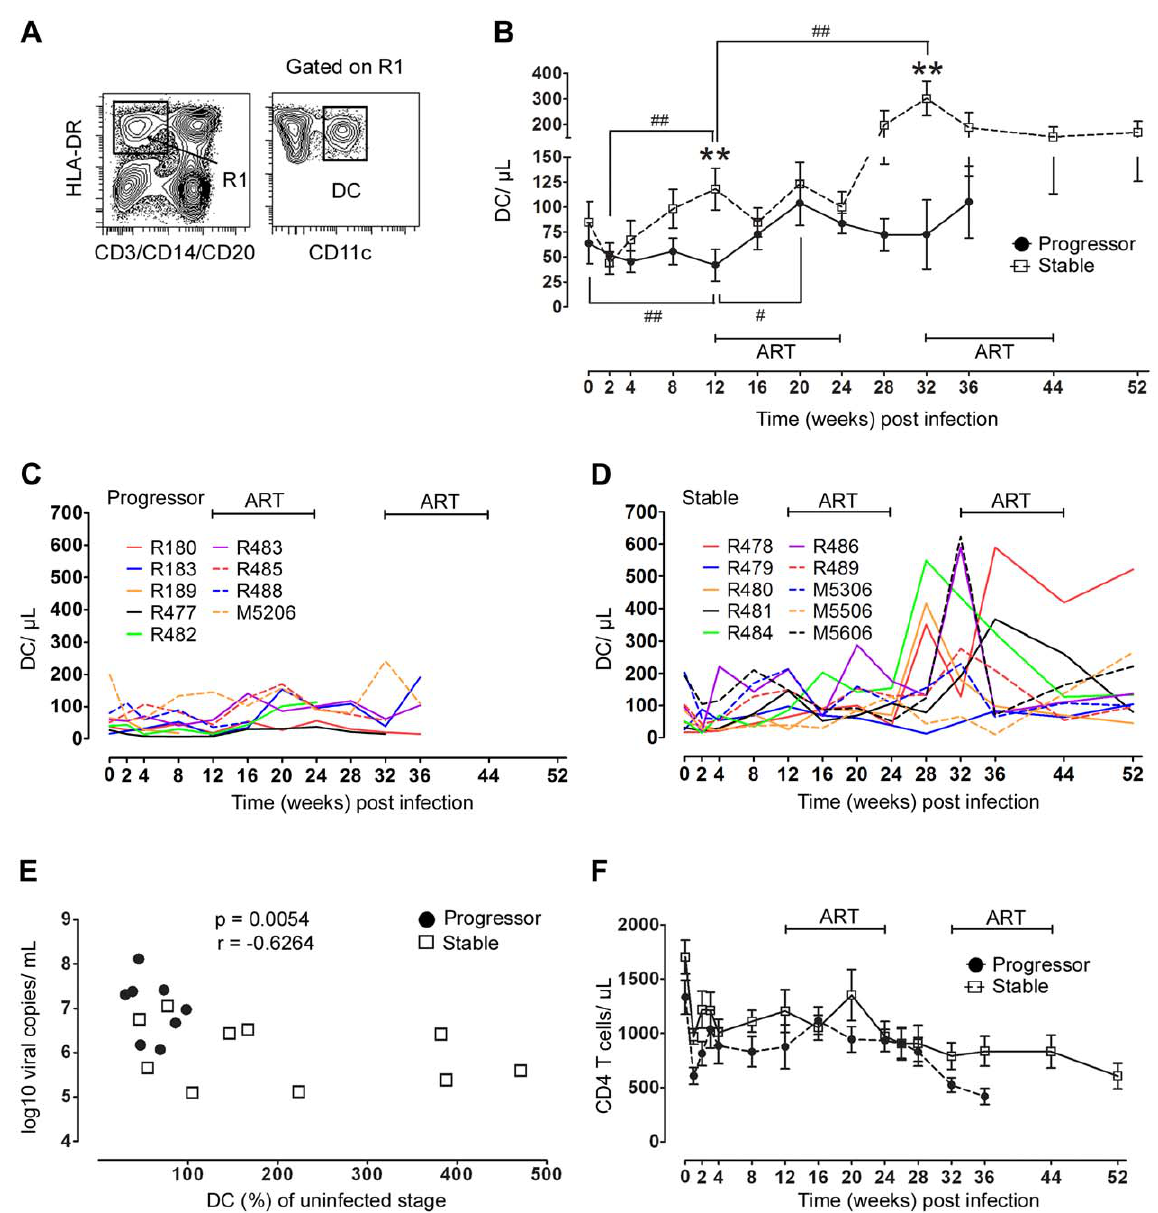
Figure 2. Divergent mDC response in blood correlates with virus load and disease progression. (A) Representative flow cytometry plots showing the gating strategy used to define CD11c + mDC within the Lineage 2 HLA-DR + fraction of PBMC. (B) Changes in the absolute number of mDC in blood over the course of SIV infection in animals with stable (n=10) and progressive (n=9) infection. Shown are mean 6 SEM. ** P , 0.01 between groups; # P , 0.05; ## P , 0.01 within groups relative to week 12 post infection. (C, D) Individual mDC counts in blood for progressor animals (C, n=9) and stable animals (D, n=10). (E) Correlation between percent change of mDC in blood from week 0 to 12 and virus load at week 12 (n=18, R189 died at week 11 and is not included). (F) Change in absolute number of CD4 T cells in blood over the course of SIV infection in animals with stable (n=10) and progressive (n=9) infection. Shown are mean 6 SEM. ART=intervals of antiretroviral therapy.